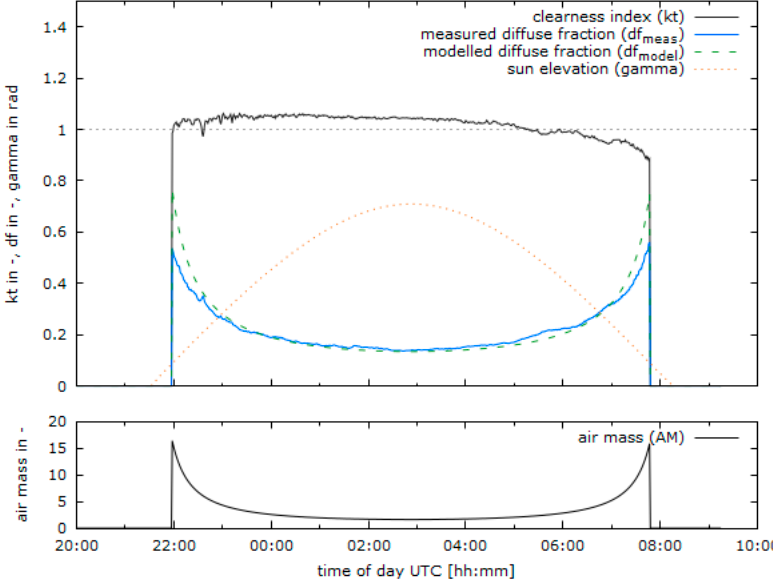
Figure 7. Example for the geometric approach used to model clear sky diffuse fraction. The data shown is from Tateno, Japan, for 13 February 2006. While kt ( top plot, black) remains relatively constant, the measured diffuse fraction (blue) follows a typical scheme, starting with high df values in the morning, falling to a minimum at noon and rising again in the evening. This behaviour shows a strong correlation with the change of the air mass during the day ( bottom plot, black). The clear sky diffuse fraction (green) is modelled as presented in Equation (9). The most important factor in this part of the model is the smallest value of df during the day, df min . Modelling df min correctly is crucial for good algorithm results.